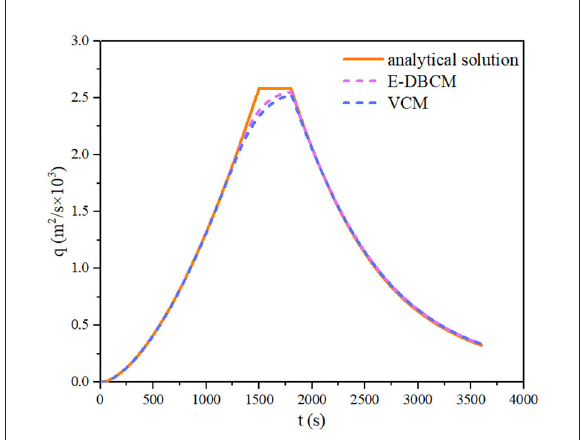
FIGURE4 Comparison of hydrographs obtained from different